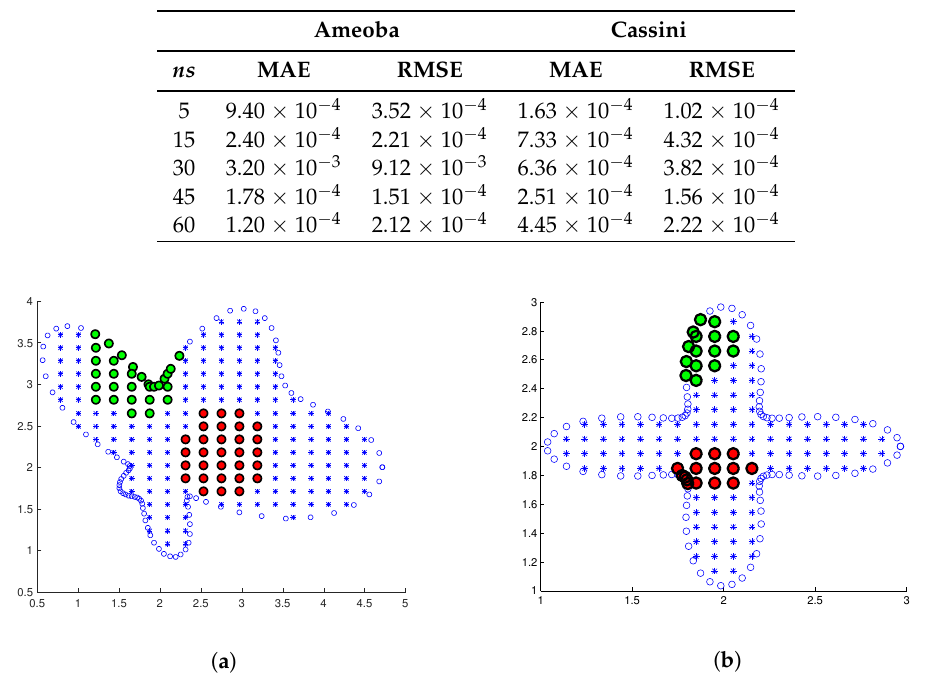
Figure 8. ( a ) Ameoba and ( b ) Cassini-shaped domain with interior (red) and boundary (green) stencil.